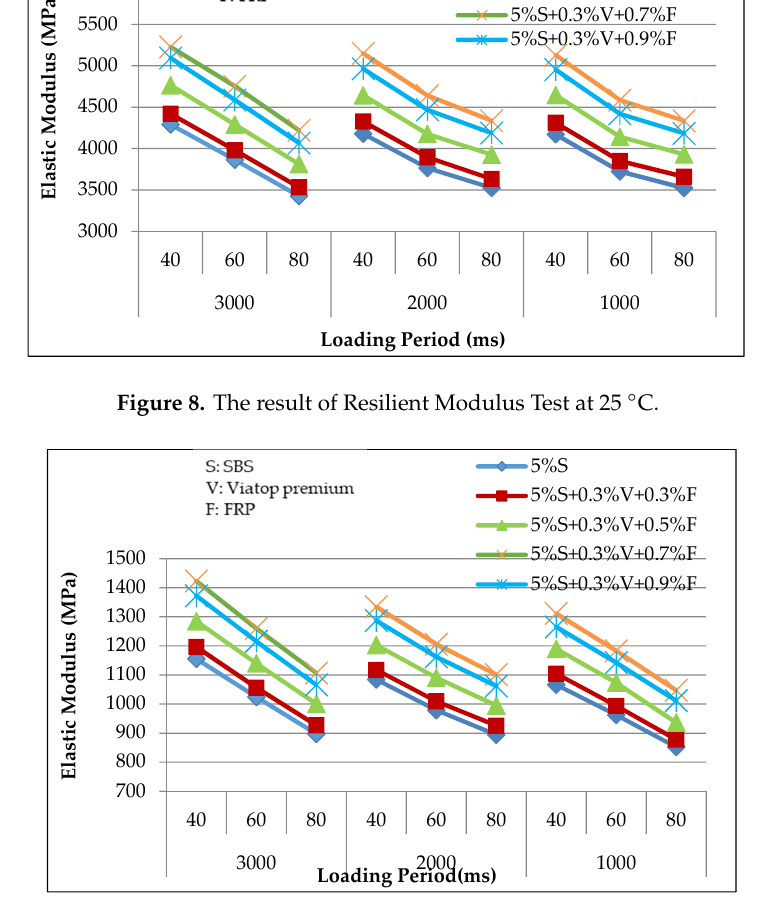
Figure 9. The result of Resilient Modulus test at 40 °C.